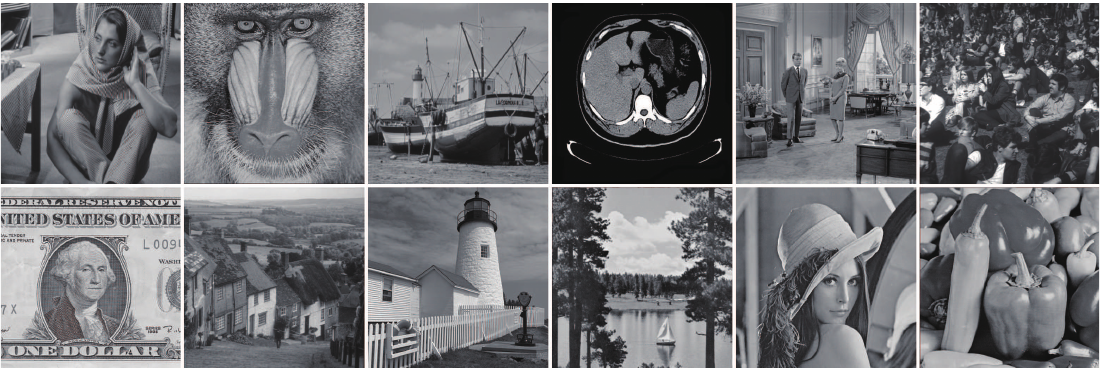
Figure 3. Twelve typical images, from left to right, from top to bottom: Barbara, Baboon, Boat, Chest, Couple, Crowd, Dollar, Goldhill, Kod, Lake, Lenna, and Peppers.